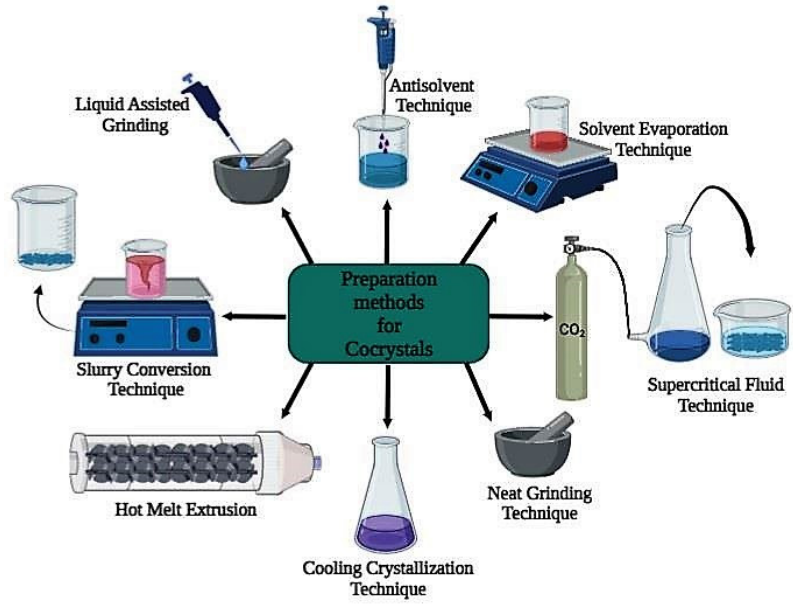
Figure 6. Conventional approaches for preparing pharmaceutical cocrystals.